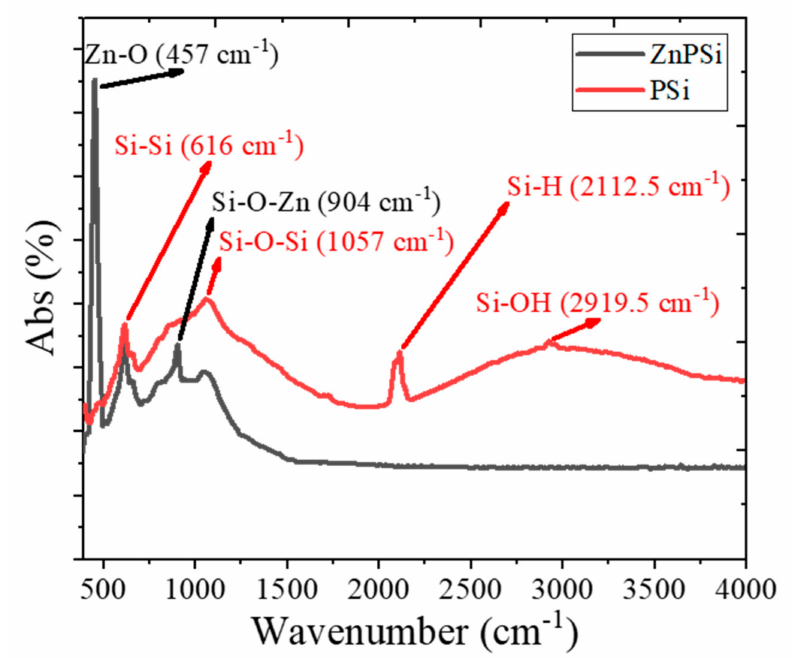
Figure 4. FTIR spectra of Psi and ZnPSi.